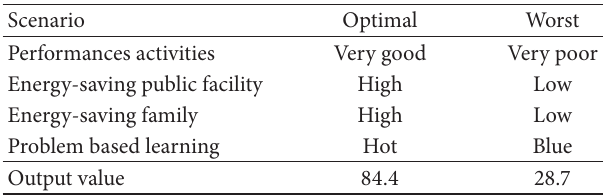
Table 4: Quantized output of the best and the worst.